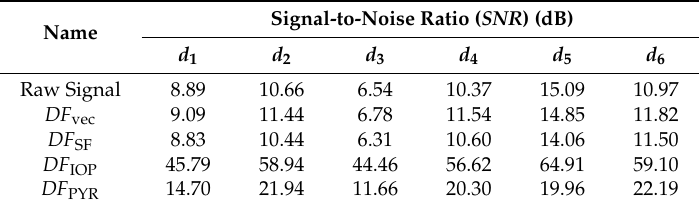
Table 2. Evaluation of data fusion scheme based on SNR